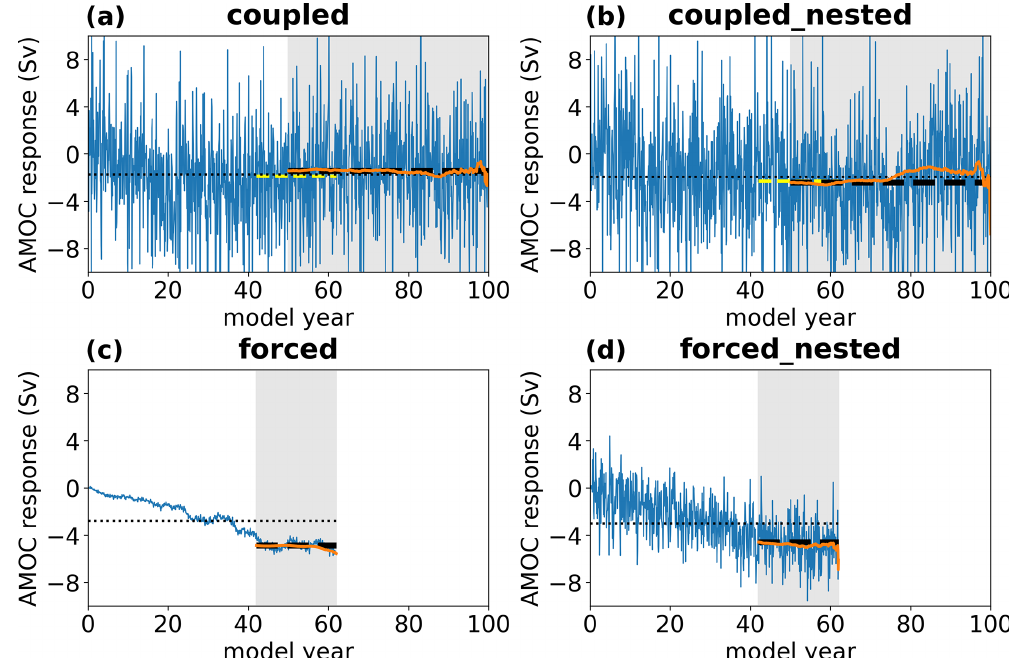
Figure A1. Difference in monthly mean AMOC strength (blue) between the perturbation experiment and the reference run of all four model configurations. Gray shading of the background marks the respective averaging periods for computing the response to the freshwater perturbation: years 51–100 for the coupled and years 43–62 for the forced experiments. The orange lines depict the running mean based on a boxcar window anchored at the end of the time series and expanding backwards in time. Dashed and dotted black lines indicate the overall mean for the response period (gray shading) and for the entire time series, respectively. The dashed yellow line in the upper panels depicts the mean of model years 43–62, which corresponds to the 20-year response period of the forced experiments (cf. lower